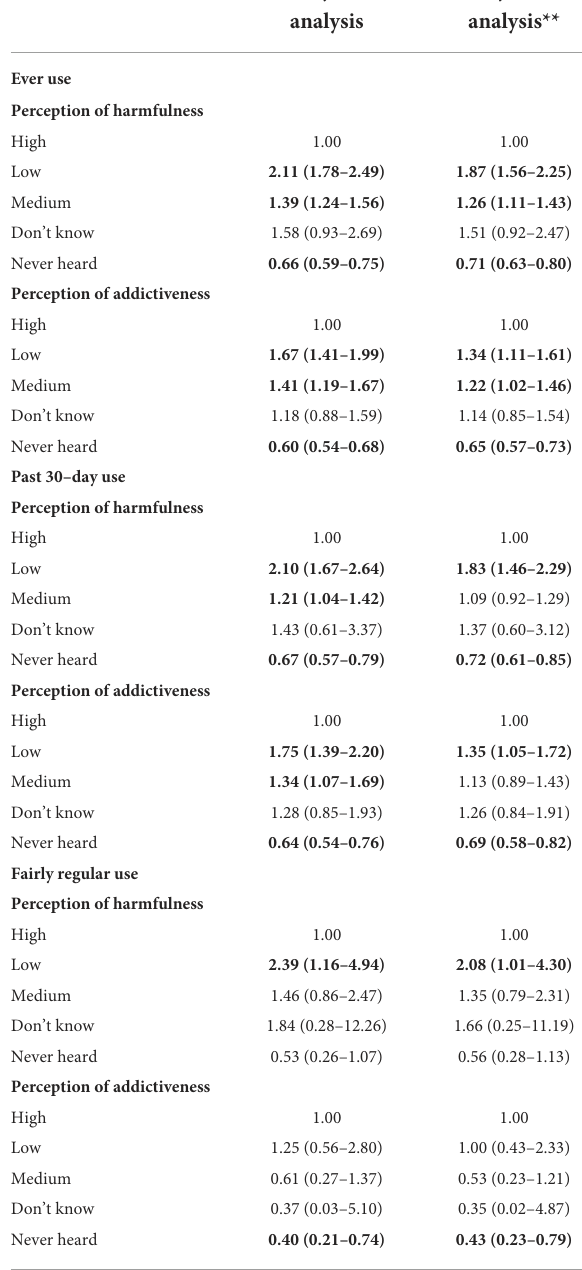
TABLE 2 Hazard ratio (and 95% confidence intervals) of perceptions of harmfulness and addictiveness for each cigar outcome * . Outcome Unadjusted